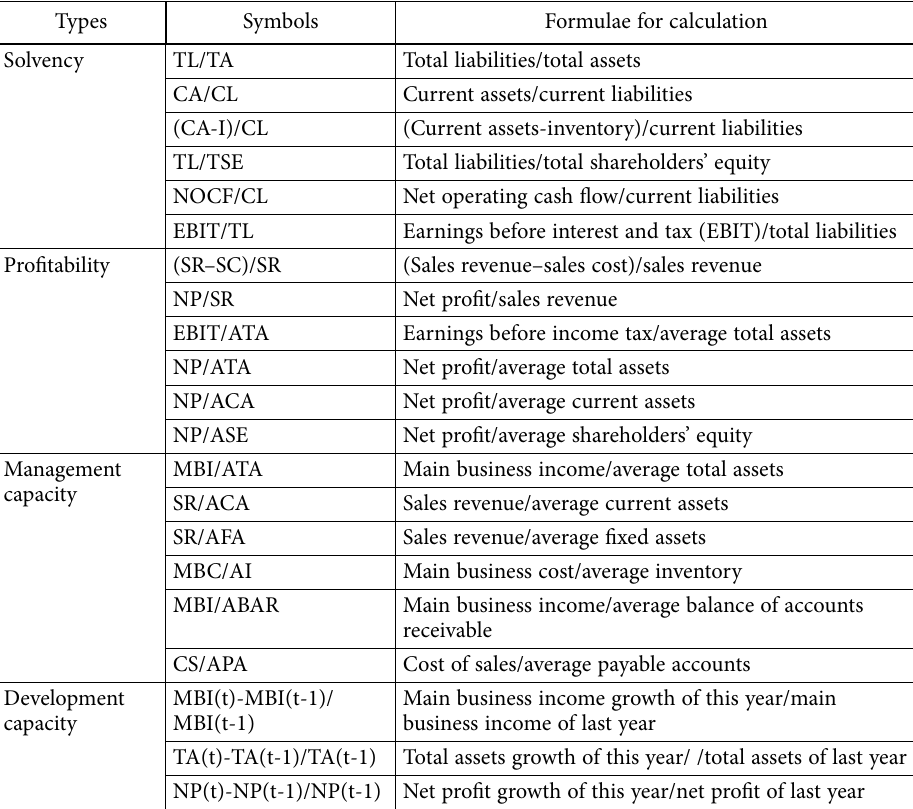
Table 4. Financial indicators for distress prediction